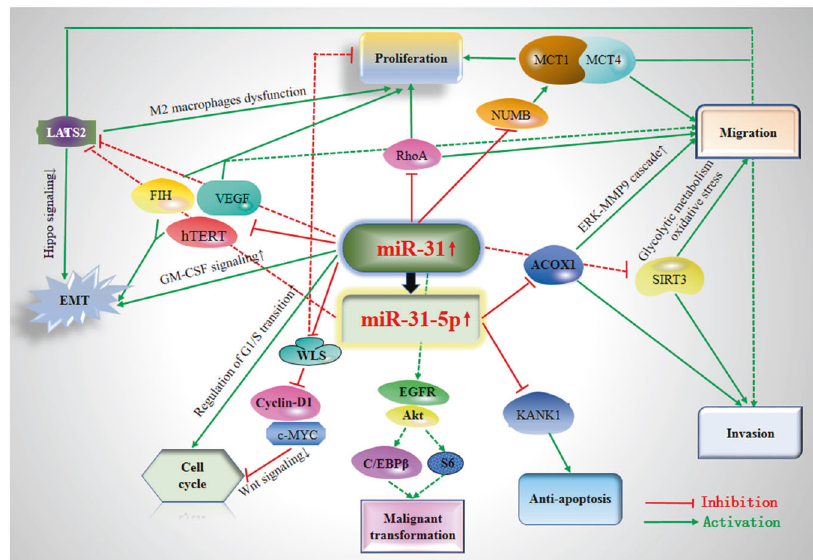
Fig. 2 Main mechanisms of miR-31 in oral squamous cell carcinoma (OSCC). miR-31 exerts its central roles in OSCC by constituting a complex network with the direct target genes (e.g. RhoA, FIH, ACOX1, VEGF, SIRT3, LATS2, KANK1, and NUMB) and the signaling cascades (e.g. ERK-MMP9 cascade, Hippo pathway, Wnt signaling, and MCT1/MCT4 regulatory cascade). RhoA = ras homolog family member A; EMT = epithelial-to-mesenchymal transition; FIH = factors inhibiting HIF; hTERT = human telomerase reverse transcriptase; VEGF = vascular endothelial growth factor; PGE2 = prostaglandin E2; ACOX1 = acyl-CoA oxidase 1; ROS = reactive oxygen species; SIRT3 = silent information regulator 3; LATS2 = large tumor suppressor kinase 2; KANK1 = KN motif and ankyrin repeat domain-containing protein 1; CASC2 = long non-